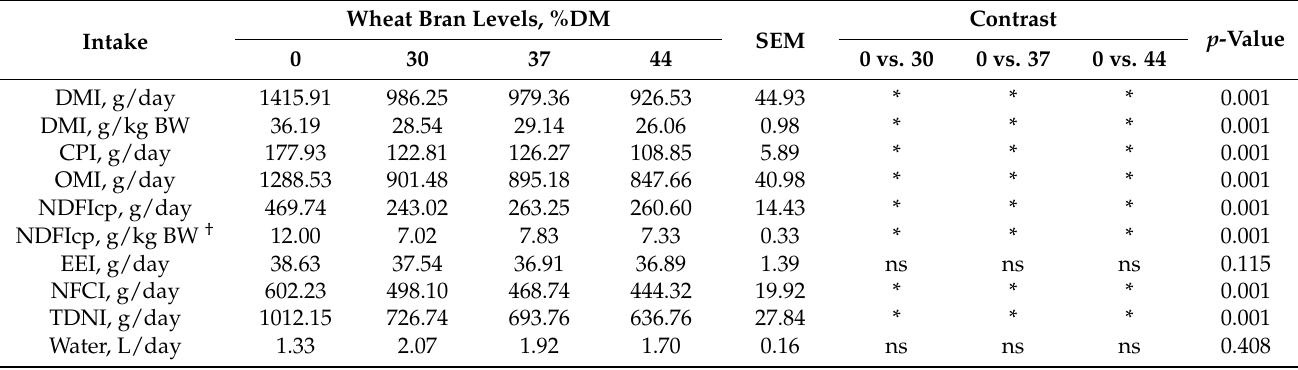
Table 3. Intake of diet’s nutrient and water of lambs fed with cactus pear as the only forage source and different levels of wheat